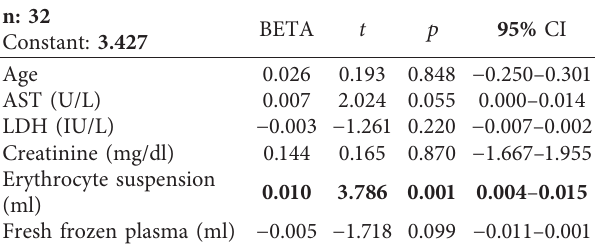
Table 4: Regression analysis in terms of factors affecting the length of stay in the ICU.